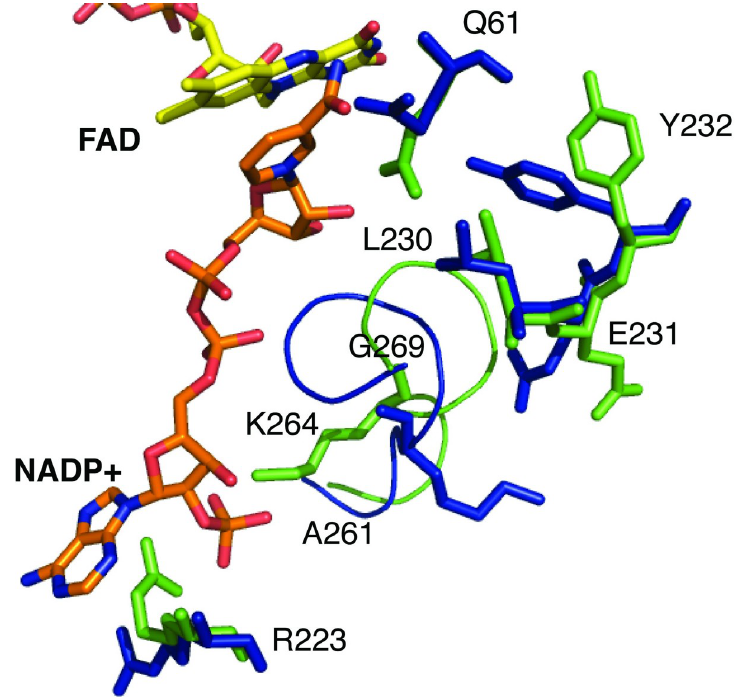
Fig 10. Structural changes upon NADP + binding. View of the superimposed active sites of the Ss DesB holoenzyme (blue; PDB code: 6XBC) and Ss DesB-NADP + bound (green; PDB code: 6XBB) structures highlighting the positional shift of residues in the active site upon NADP +